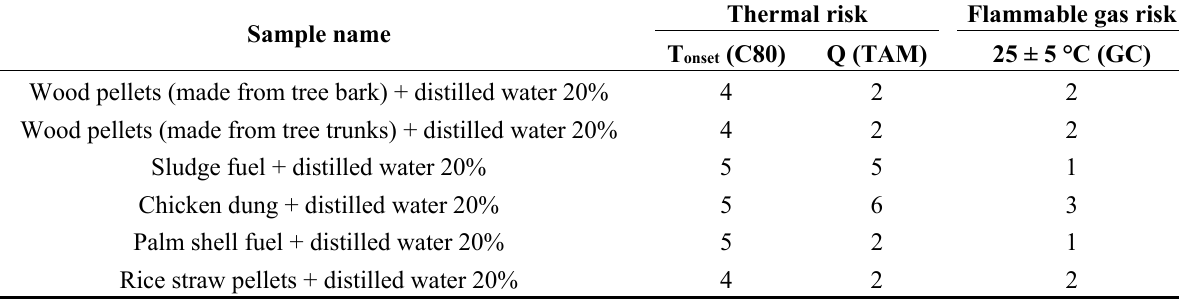
Table 5. Risk ranking of the tested samples + distilled water 20%.